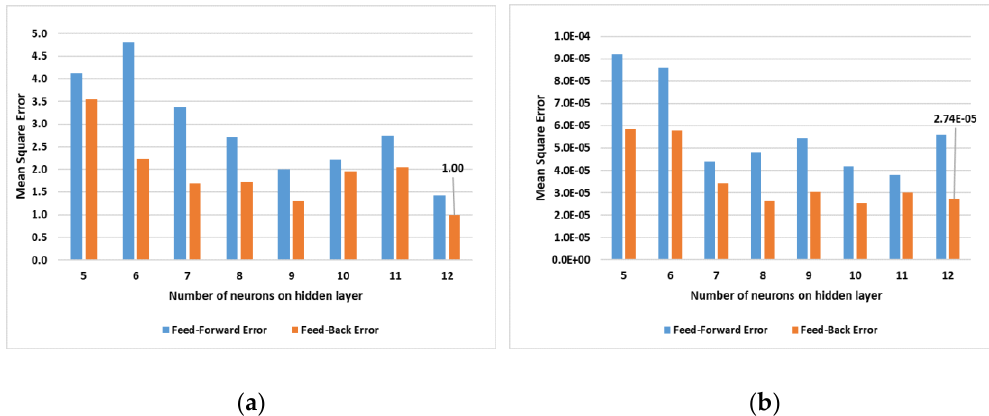
Figure 8. The obtained results by varying number of neurons on hidden layer for 1500 iterations: ( a ) original data; ( b ) normalised data.